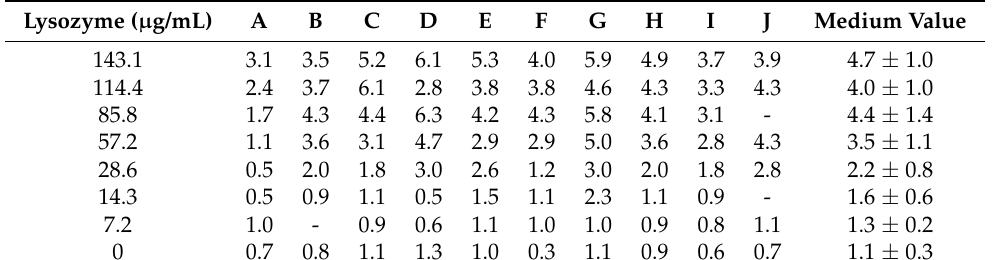
Table 2. ∆ E 76 values obtained by direct comparison of the samples with the medium values of all zero samples. Shaded values are over the Just Noticeable Difference (JND) threshold, with darker shaded ones being over the color difference threshold.